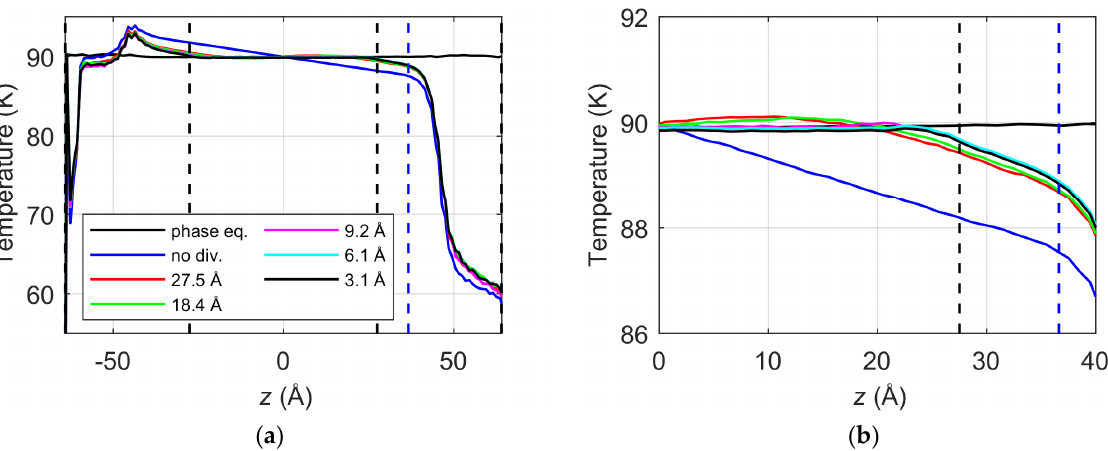
Figure 6. ( a ) The temperature profiles from simulations with different thermostat region division bin widths, and ( b ) the zoomed view of these profiles in the liquid region near the liquid surface. The black dotted lines denote the liquid/thermostat and vapor boundary positions 𝑧 ∗ = −0.9 and 𝑧 ∗ = 3 for both left- and right-side interfaces, while the blue dotted line denote the liquid surface position 𝑧 ∗ = 0 . For comparison, the temperature profiles from the phase equilibria simulation and the steady-state vacuum simulation with no bin division are also plotted.